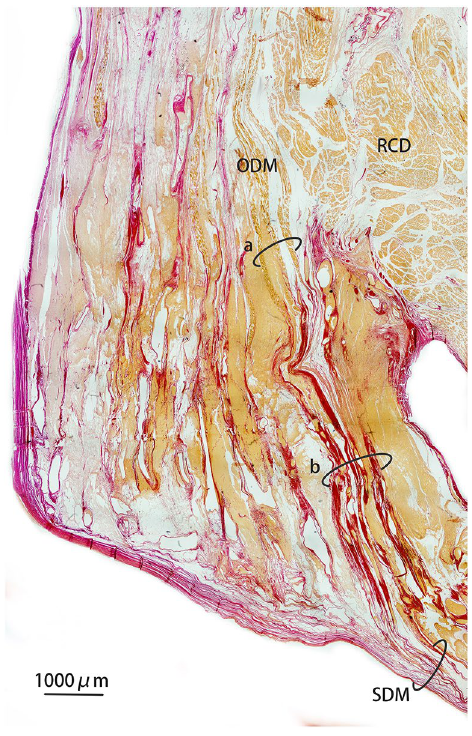
Figure 5. Van Gieson (VG, picric acid and acid fuchsin) stained histological sagittal section of from the suboccipital region of N.asiaeorientalis . Images were achieved utilizing a 4 × light microscope. RCD: rectus capitis dorsalis. ODM: occipital-dural muscle. SDM: spinal dura mater. ( a ) fibers of the muscle belly of the occipital-dural muscle. ( b ) fibers of the muscle tendon of the occipital-dural